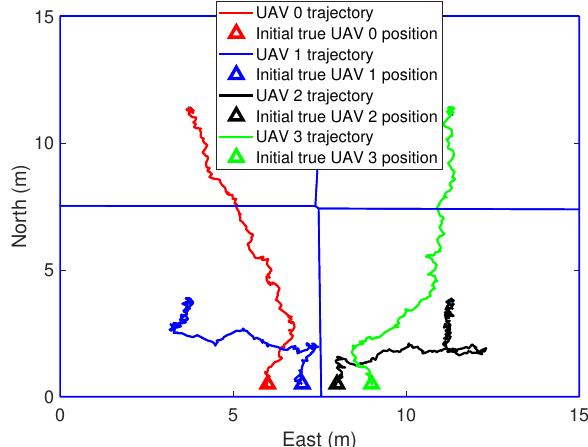
Figure 9. The process of coverage task performing, k = 200